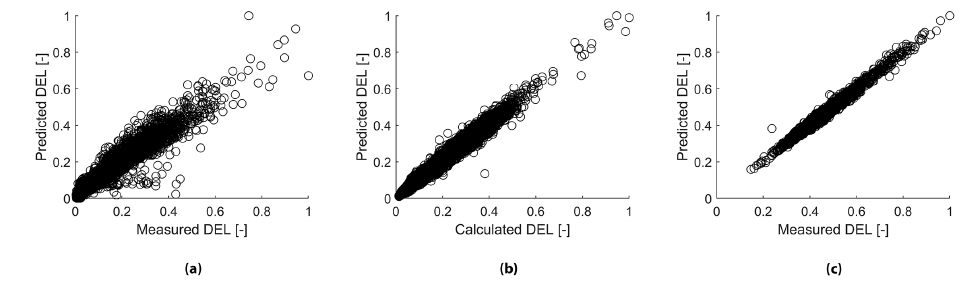
Figure 7. Normalized measured vs. predicted DELs. Figures correspond to a model built with features from the correlation analysis. Sub- figure (a) : standstill. Subfigure (b) : partial load. Subfigure (c) : full load. Table 4. Summary of results from neural networks for different operational